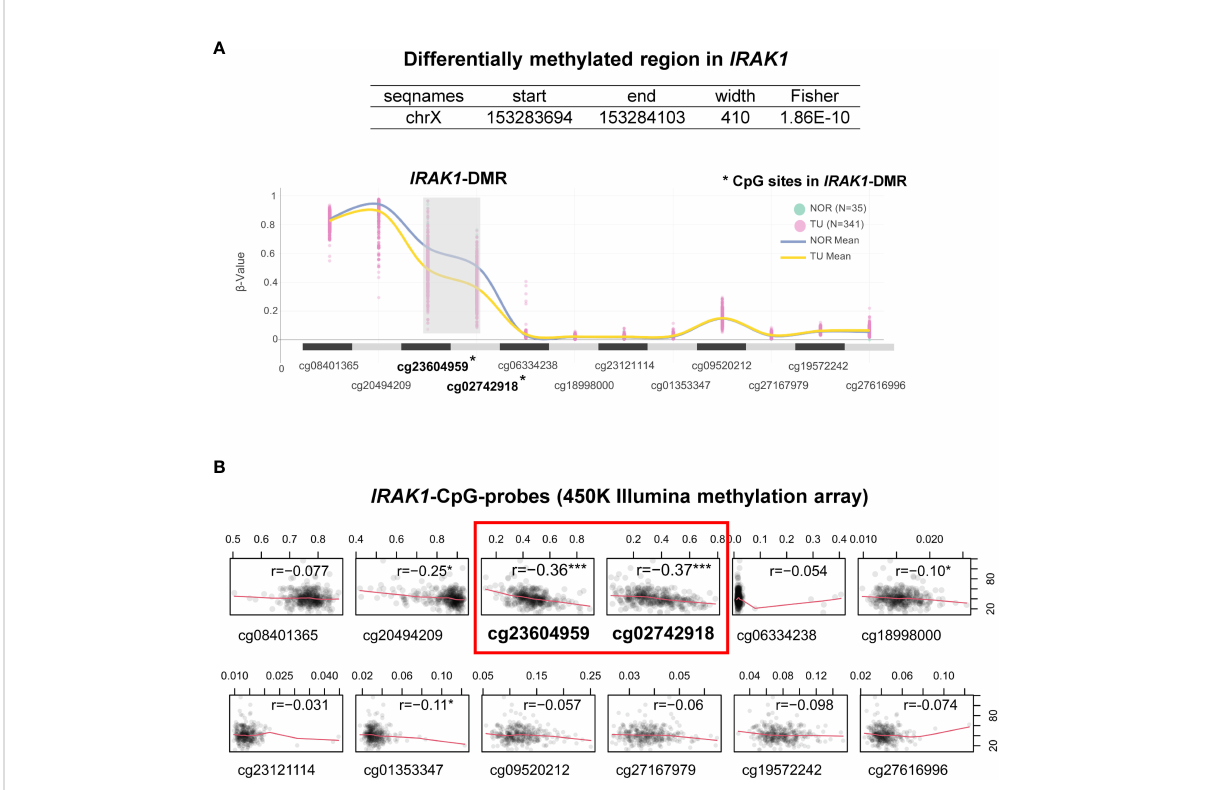
FIGURE 3 Characterization of the Differentially Methylated Region in IRAK1 ( IRAK1 -DMR). (A) A snapshot of graphical user interface from ChAMP (Chip Analysis Methylation Pipeline) package showing a trend of DNA methylation levels ( b -values) at different CpG-sites (presented as CpG-probes cg-number) in normal prostate (NOR) and prostate cancer tissue (TU). Lines represent mean methylation levels of analyzed CpG-probes (NOR, blue; TU, yellow). (B) Correlation plots of IRAK1 -mRNA levels and IRAK1 -methylation values in different CpG-probes (Spearman ’ s correlation coef fi cient r is indicated for each correlation analysis). *CpG-sites located within IRAK1 -DMR. Signi fi cance levels: ***p<0.001,